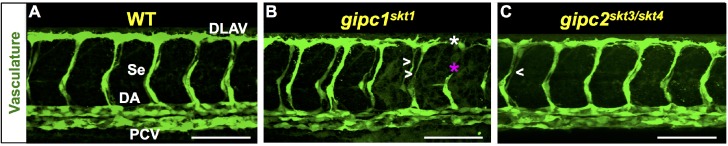
Angiogenesis deficits of gipc1skt1 and gipc2 skt3/skt4 mutants at 32 hpf.(A–C) Confocal lateral images of the trunk vasculature (green) of 32 hpf embryos (region dorsal to the yolk extension). Anterior, left; dorsal, up. Scale bars (white horizontal lines), 100 μm. Genotypes indicated on top of each image in yellow font. Angiogenesis deficits are indicated as follows: white asterisks (DLAV gaps), magenta asterisks (truncated Se), white greater/less-than signs (thin Se). In the WT image (A), the vessels are designated with the white font as follows: DLAV (Dorsal Longitudinal Anastomotic Vessel), Se (Segmental Vessel), DA (Dorsal Aorta), and PCV (Posterior Cardinal Vein). Related to Figure 4.